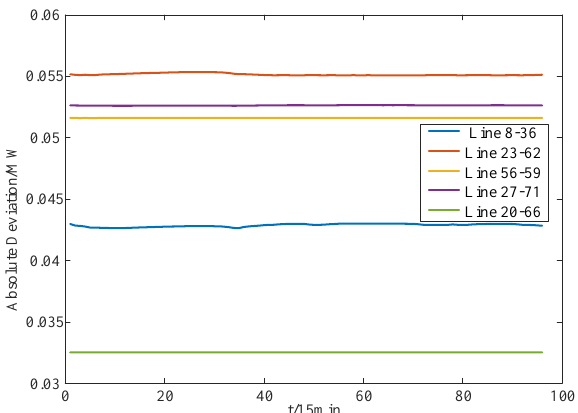
Figure 9. Absolute deviation between the values of the two sides of quadratic equality (25) on di ff erent lines.